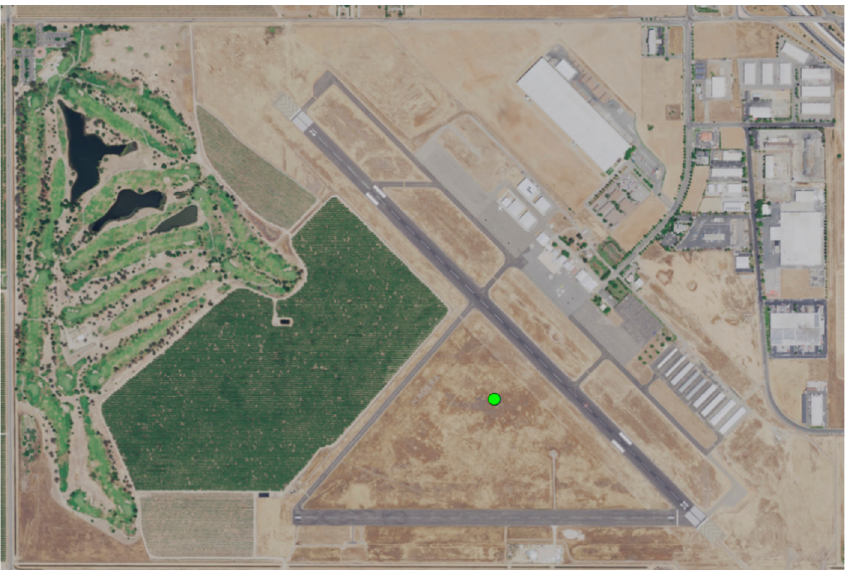
Figure 2. NAIP imagery example with AHA overlay indicated with a green dot. Table 2. Total images for each CI facility type.